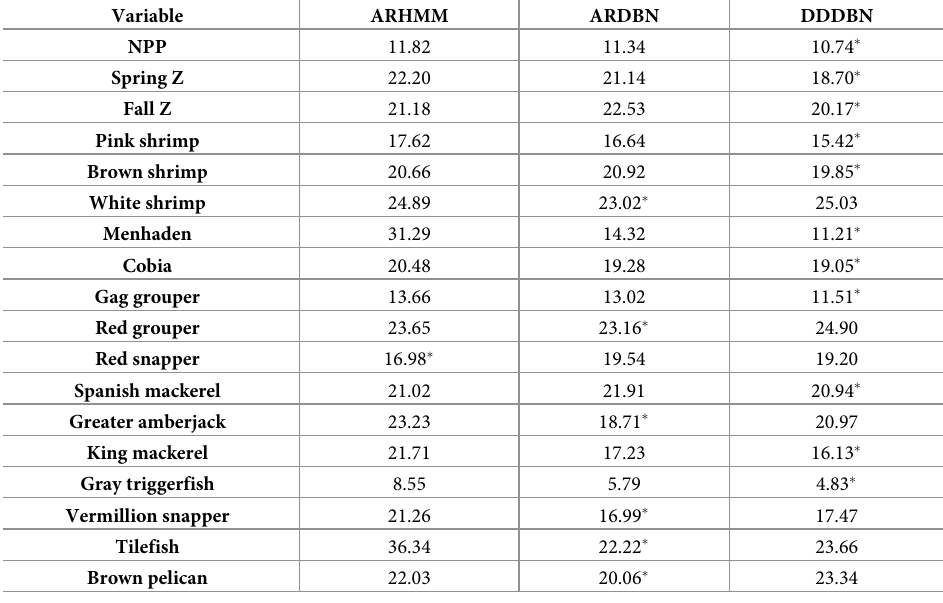
� symbol indicates most accurate predictions among the three models for each individual ecosystem